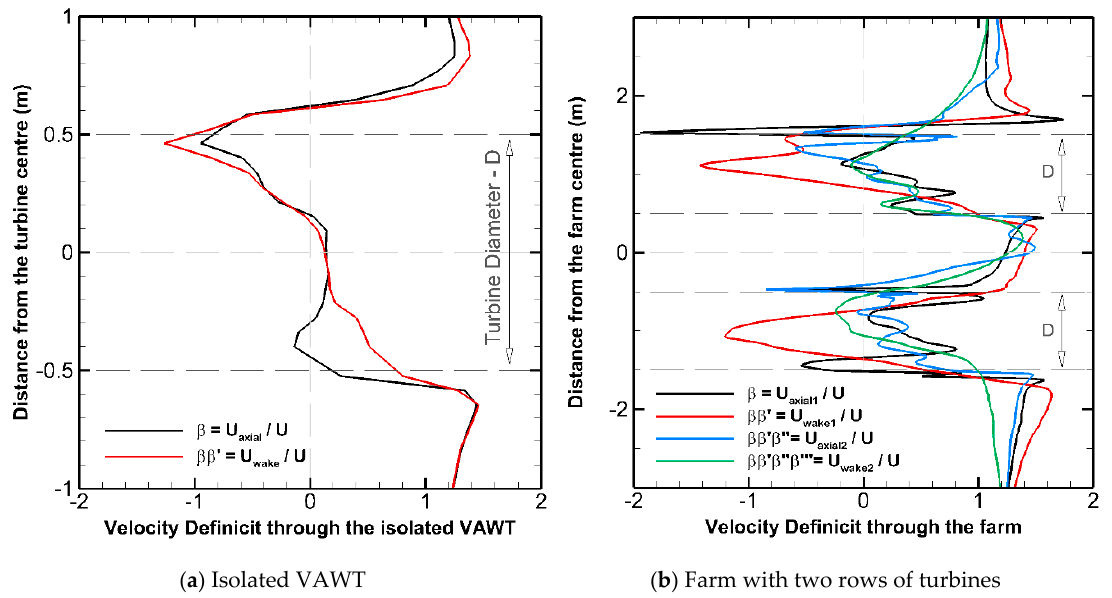
Figure A2. Velocity deficits for individual VAWT and farm of turbines: ( a ) Isolated VAWT and ( b ) Farm with two rows of turbines.